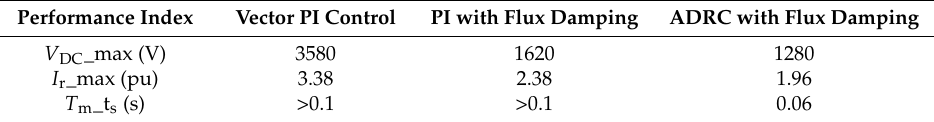
Table 3. Performance index comparison for the symmetrical 80% voltage dip case.